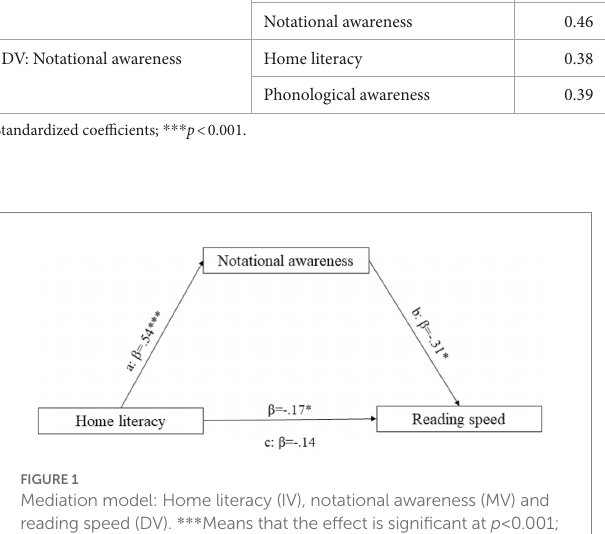
FIGURE 1 Mediation model: Home literacy (IV), notational awareness (MV) and reading speed (DV). *** Means that the effect is significant at p < 0.001; ** the effect is significant at p < 0.01; * the effect is significant at p < 0.05. All presented effects are unstandardized; a is the effect of home literacy on notational awareness; b is the effect of notational awareness on reading speed; β is the indirect effect of home literacy on reading speed; c is the total effect of home literacy on reading speed.